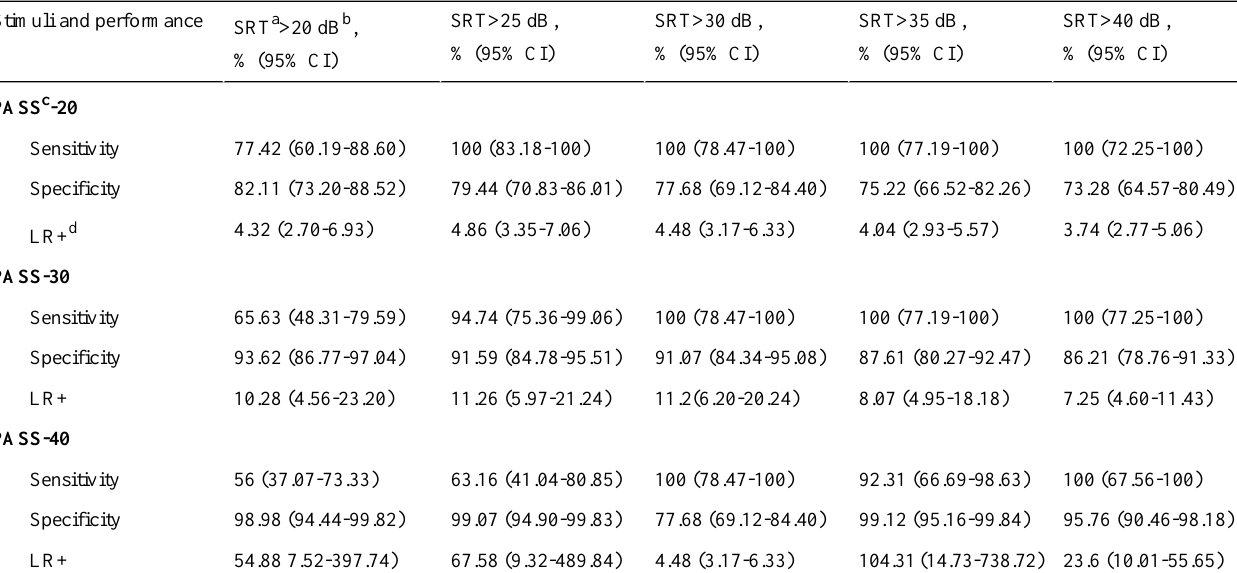
Table 3. The sensitivity, specificity, and positive likelihood ratio of the Preschool Audiometry Screening System speech audiometry app version 2 compared with speech reception thresholds.